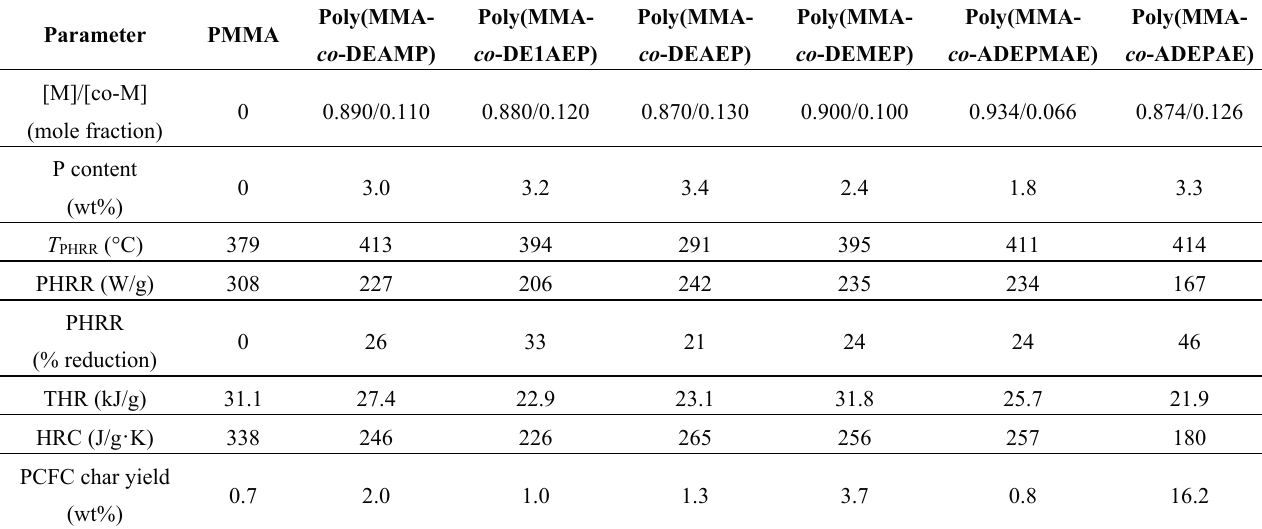
Figure 5. Plots of HRR versus temperature for PMMA, poly(MMA- co -DE1AEP), poly(MMA- co -DEAEP), and poly(MMA- co -ADEPAE). Table 6. PCFC parameters for homo- and co-polymers of